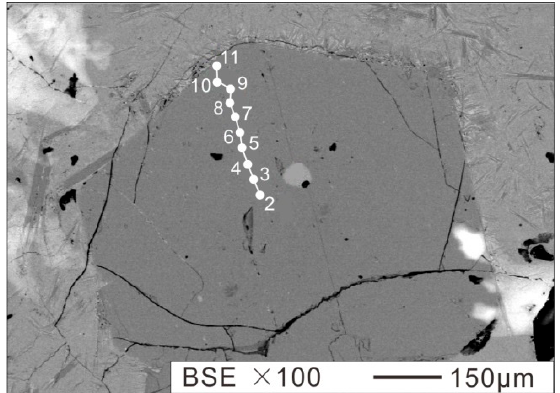
Figure 9. Backscattered electron image for typical olivine phenocryst (SA1-1).